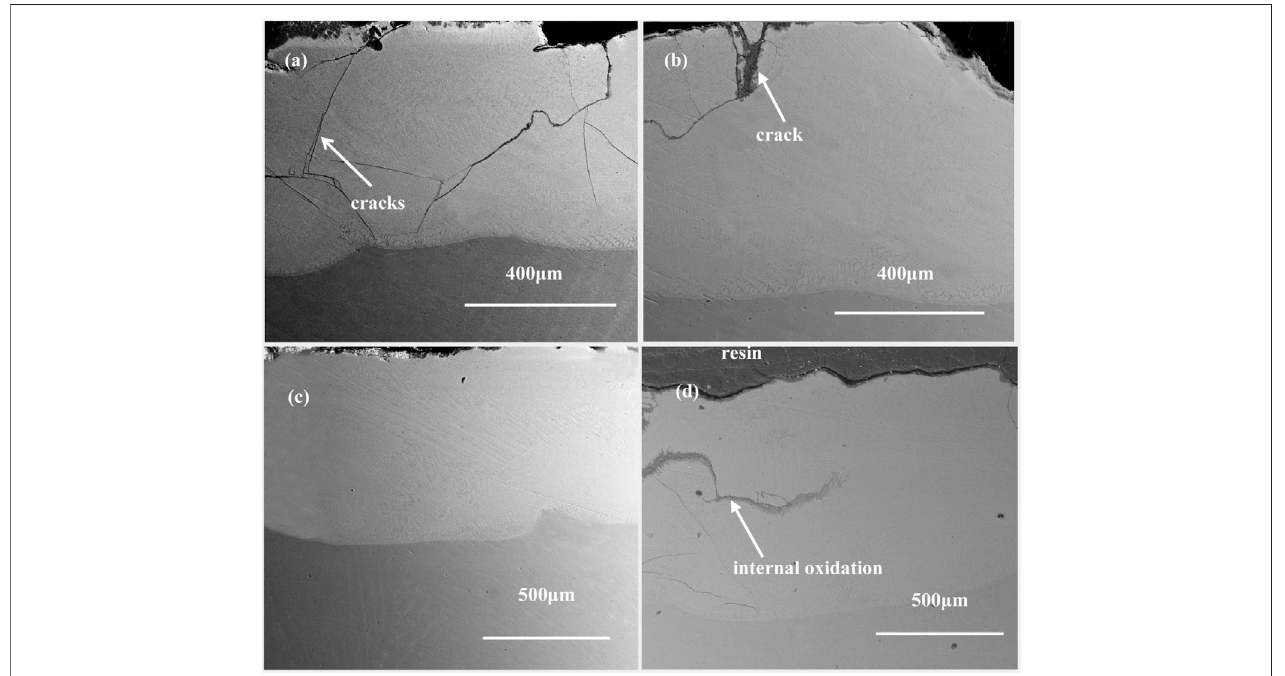
FIGURE 9 | Cross-sectional morphologies of the cotaings containing (A) 0 wt% Sm 2 O 3 ; (B) 1 wt% Sm 2 O 3 ; (C) 3 wt% Sm 2 O 3 ; (D) 5 wt% Sm 2 O 3 after oxidation at 900 ° C for 100 h.